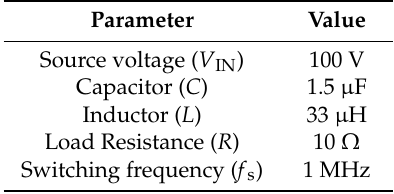
Table 1. Specifications of the SiC MOSFET based half-bridge dc-ac converter.